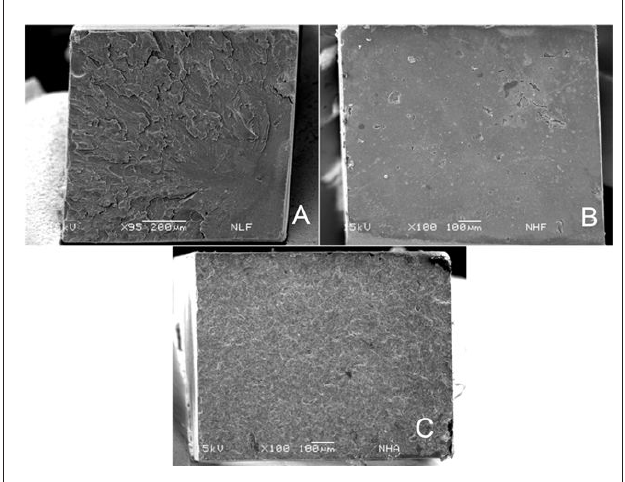
Fig. 3. (A) Fractured end of specimen cemented with Nexus 2 (high viscosity and dual-cure) exhibiting cohesive failure within the adhesive resin (original magnification X95). (B) Fractured end of specimen cemented with Nexus 2 (high viscosity and dual-cure) exhibiting adhesive failure between adhesive and resin cement (original magnification X100). (C) Fractured end of specimen cemented with Nexus 2 (high viscosity and self-cure) exhibiting cohesive failure within the resin cement (original magnification X100).